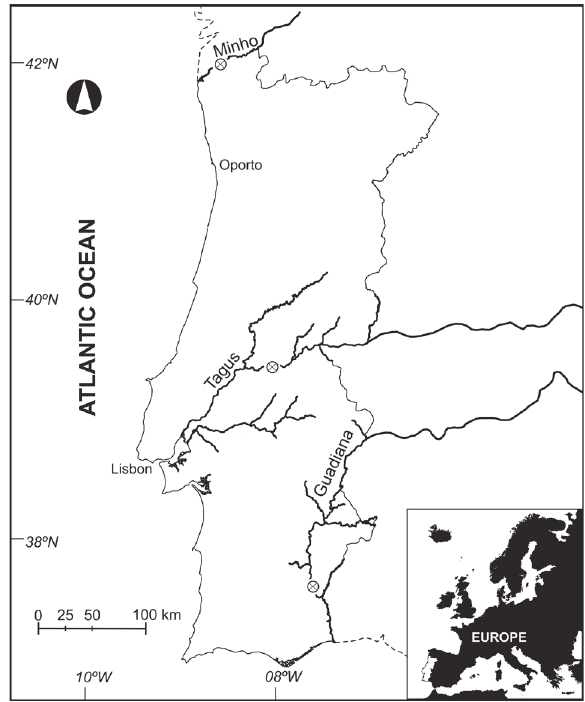
Fig . 1. – location of the sampling sites ( U ) in the rivers minho, tagus and